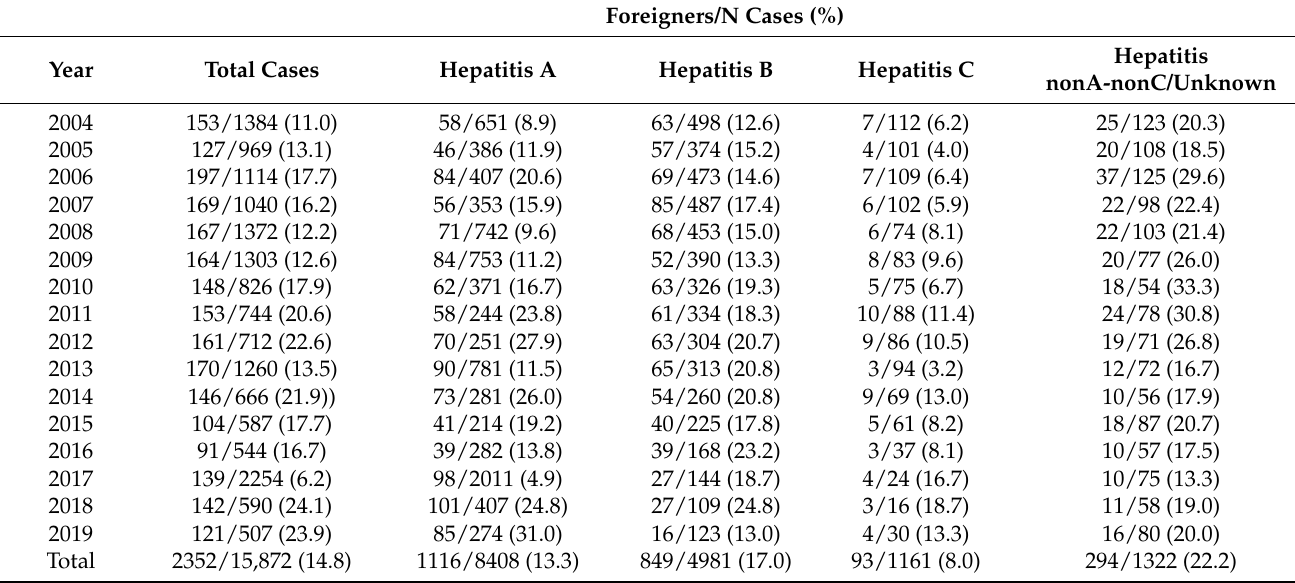
Table 1. Absolute distribution and percentage of foreign citizens among acute viral hepatitis cases by type of hepatitis and by year. SEIEVA 2004–2019.